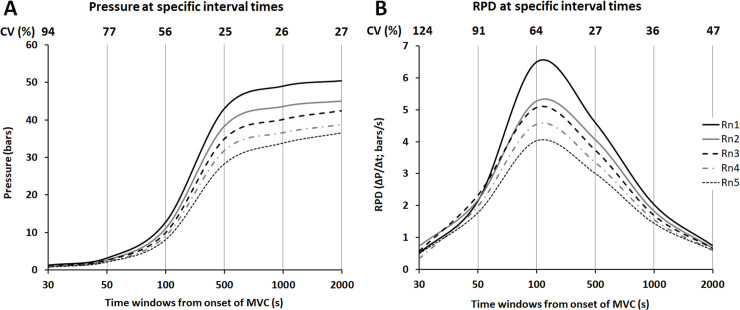
Averaged representation of the pressure (A) and Rate of Pressure Development–RPD- (B) values computed from all participants across specific time intervals in the five normalized rounds (Rn). Presentation of the relative coefficients of variation (CV, %), as representative of the variability between subject, at each time window from the onset of maximal voluntary contraction (MVC).